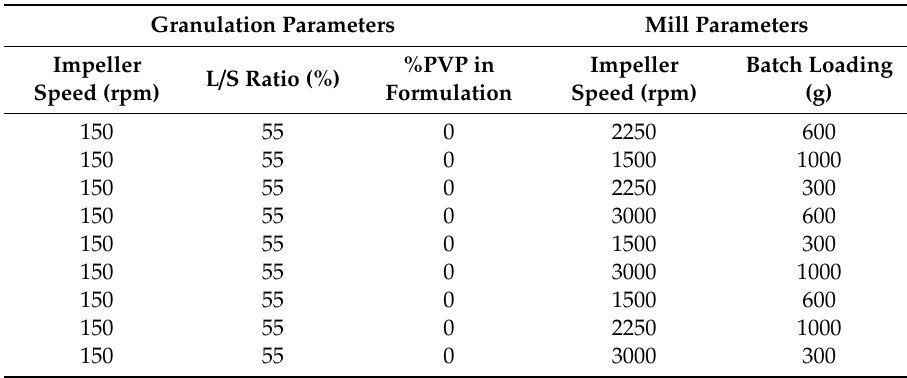
Table 1. DoE for e ff ect of mill process